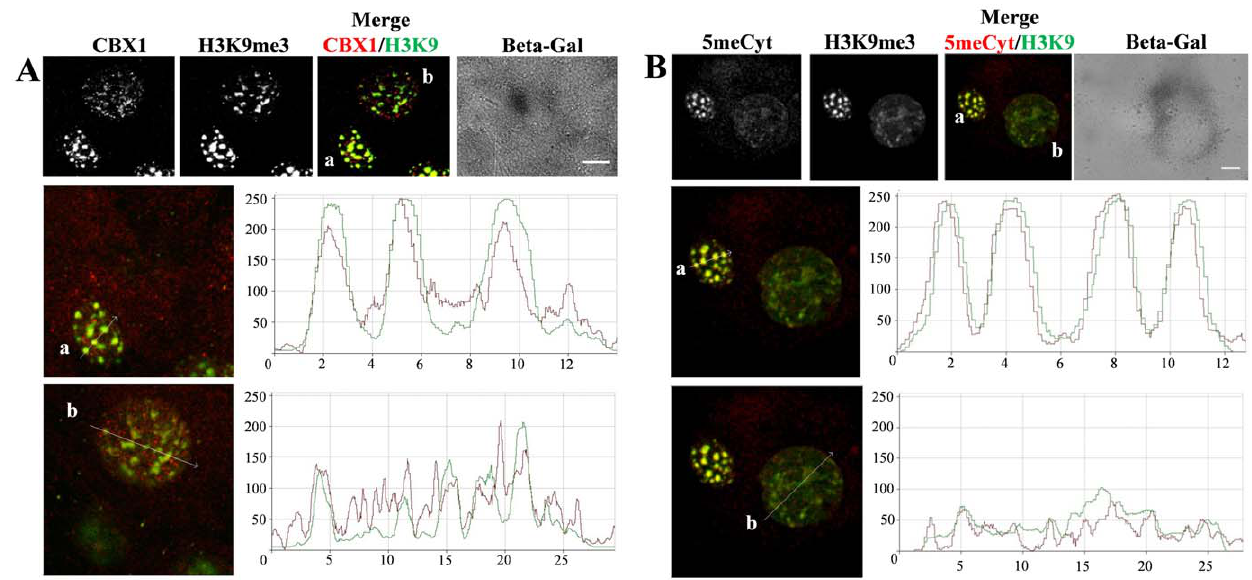
Figure 3. Heterochromatin markers in young and senescent bovine cells at passage 18. ( A ) Young and senescent cells exhibit different fluorescence intensity levels both H3K9me3 (green) and CBX1 (red) when compared in one optical field.Upper panel: Z-stack projection images after immunostaining of H3K9me3 and CBX1 and beta-gal assay. Scale bars: 5 m m. Middle panel (a): profiles of fluorescence intensities (right) of H3K9me3 (green) and CBX1 (red) mainly overlap when obtained from a single confocal section of the young cell nucleus. Lower panel (b): A senescent cell exhibits significantly lower levels of both CBX1 and H3K9me3 than a young cell. Horizontal and vertical axes correspond to micrometers and eight-bit fluorescence intensity levels, respectively. ( B ) Different levels of both H3K9me3 (green) and 5-methylcytosine (red) in young (a) and senescent (b) cells. Upper panel: Z-stack projection images of young (a) and senescent (b) cells were immunostained for H3K9me3 and 5-methylcytosine and captured in one optical field. Scale bars: 5 m m. Middle (a) and lower (b) panels: profiles of fluorescence intensities (right) of H3K9me3 (green) and 5- methylcytosine (red) obtained from a single confocal section of the nucleus in a young cell (left; a) and a senescent cell (left; b). Note significantly lower levels of both marks in the senescent cell as compared to the young cell.